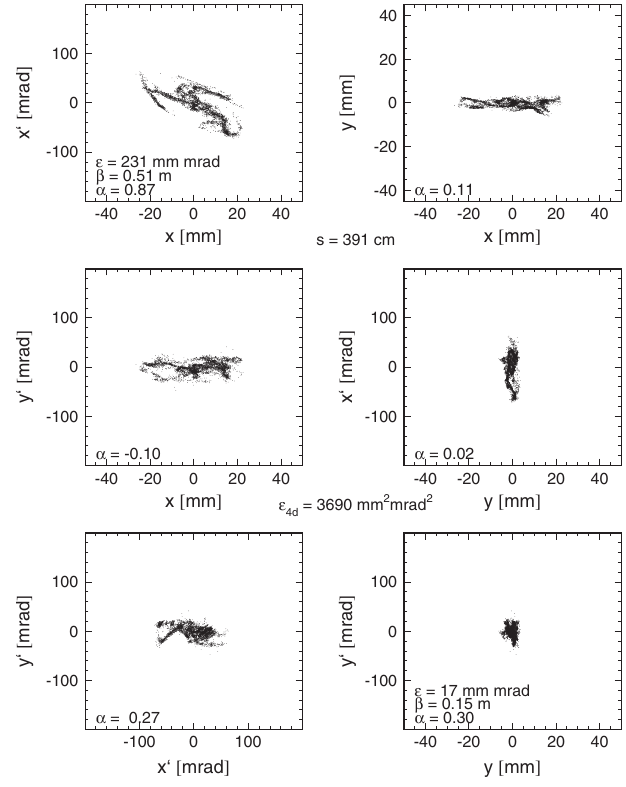
FIG. 4. From top to bottom: horizontal beam envelope, vertical beam envelope, horizontal rms emittance, and vertical rms emittance along the emittance transfer section for the ECR distribution.